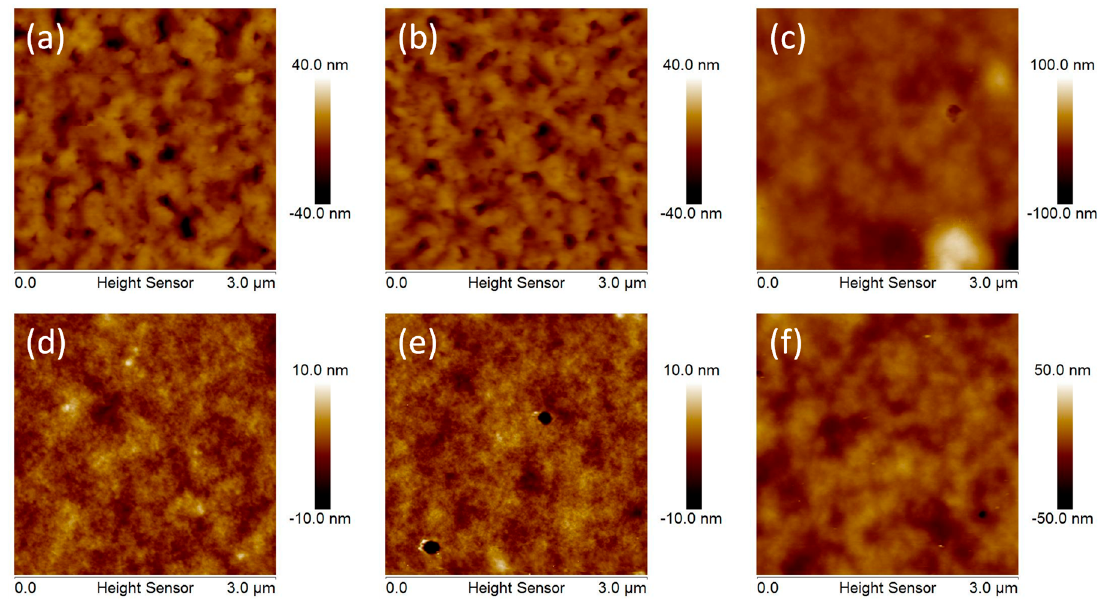
Figure 6. Atomic force microscopy (AFM) height images of ( a ) P1:PC 71 BM, ( b ) P2:PC 71 BM, ( c ) P3:PC 71 BM, ( d ) P1:ITIC, ( e ) P2:ITIC, and ( f ) P3:ITIC blend films.